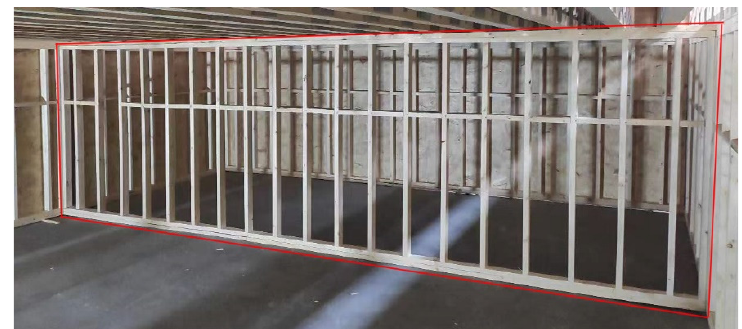
Figure 7. Partition wall.